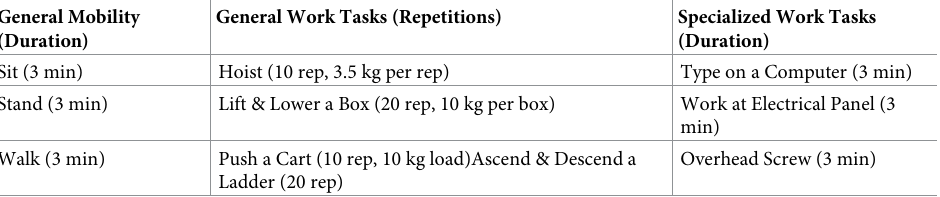
Table 3. The experimental tasks, which are performed in a columnwise order by row, i.e., first column ! second column ! third column. General Mobility